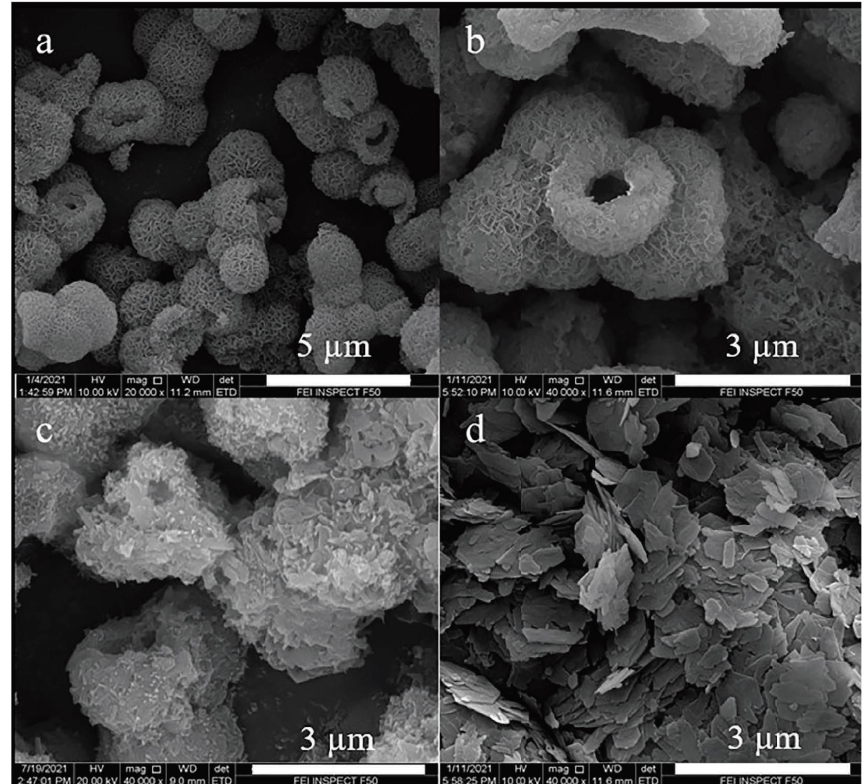
Figure 2: SEM images of (a) Mg-Ca-Al HTLCs MS, (b) calcined Mg-Ca-Al HTLCs MS (calcined at 773 K), (c) KF/Mg-Ca-Al HTLCs MS (HTLCs MS calcined at 773K), and (d) Mg-Ca-Al HTLCs prepared without the addition of citric acid.